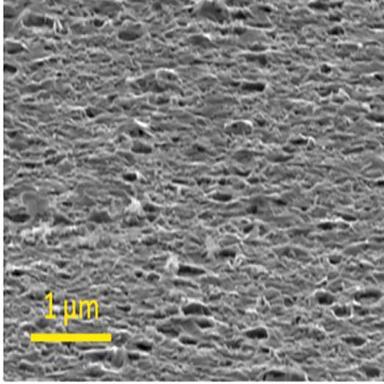
s) surface and x) cross-section SEM images obtained at 30 kV with 50 k magnification of BZT thin films deposited at: a) 350º C, 60 min; then b) annealed at 550º C, 60 min in O2. Deposited at c) 550º C, 50 min with O2:Ar.= 50%.